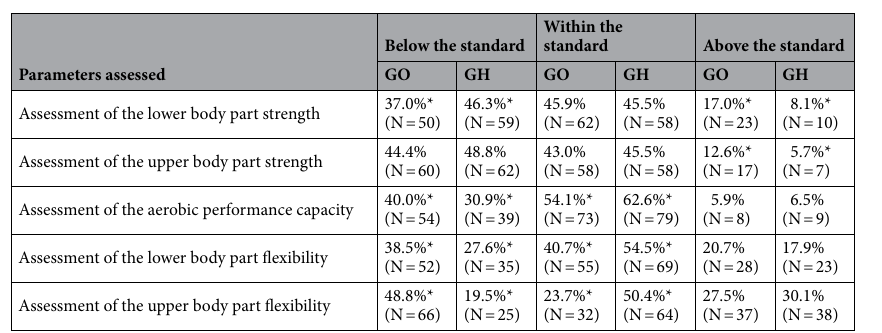
Parameters assessed